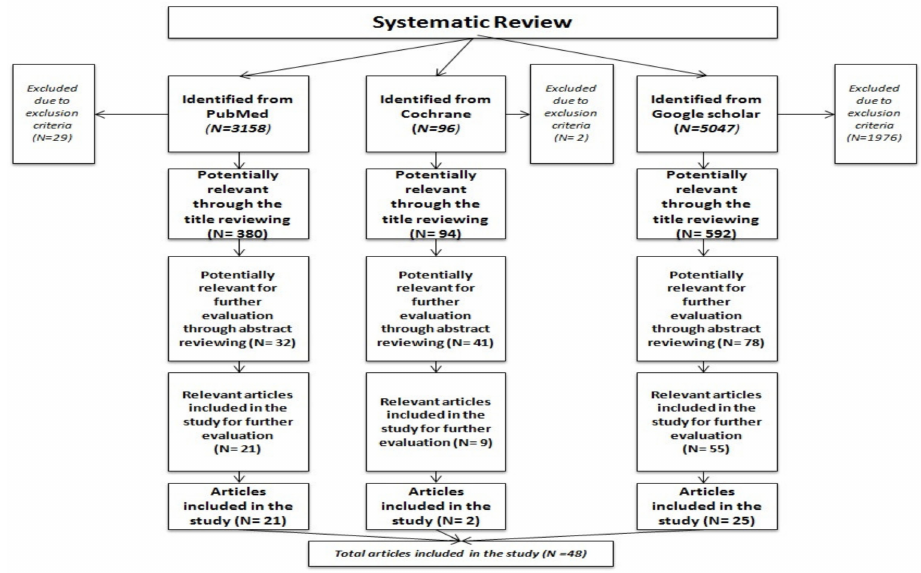
Figure 1. Flow chart of eligible assessment and review